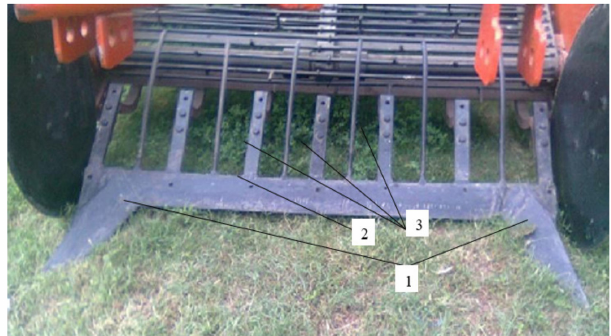
Figure 2. General view of the sub digging body: 1, ripping element; 2, digging element; 3, slotted pre-separation apertures.